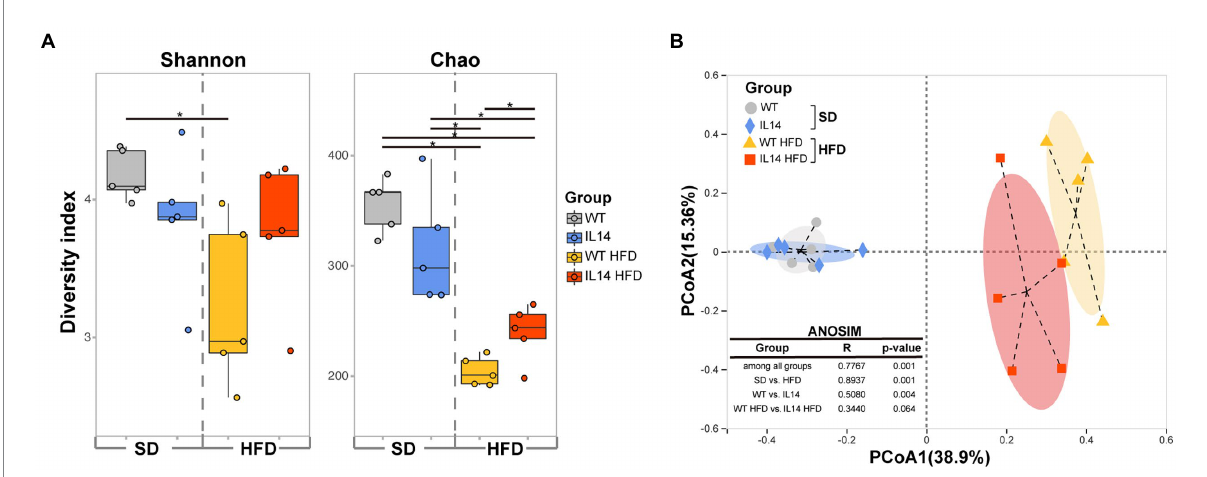
FIGURE 5 HFD altered diversity of gut microbiota in the IL-14 α TG mice. (A) Alpha diversity comparison based on the Shannon diversity index and the Chao richness index with dot plots and box plots. (B) Principal coordinate analysis plot generated using operational taxonomic unit (OTU) metrics based on the Bray–Curtis dissimilarities. Each point represents a sample. * p ≤ 0.05, n = 5 per group. SD, Standard diet; HFD, High-fat